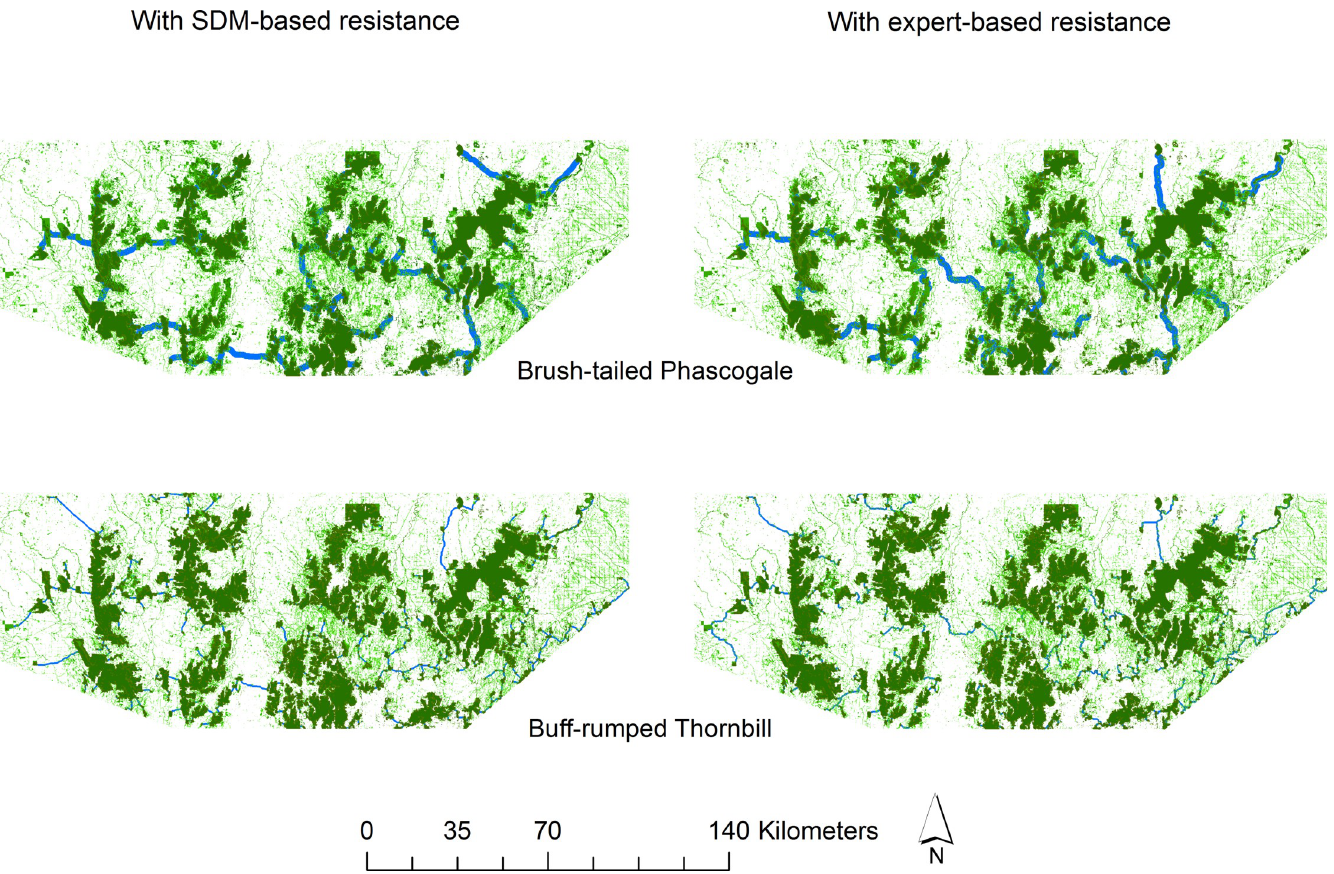
Fig 3. Least-cost paths identified for two species with two types of resistance surface. Left panel: from resistance surfaces based on species distribution models; Right panel: from resistance surfaces based on expert assigned scores; Top panel: for brush-tailed phascogale; Bottom panel: for buff-rumped thornbill. Habitat patches are shown in green, and least-cost paths are shown with blue